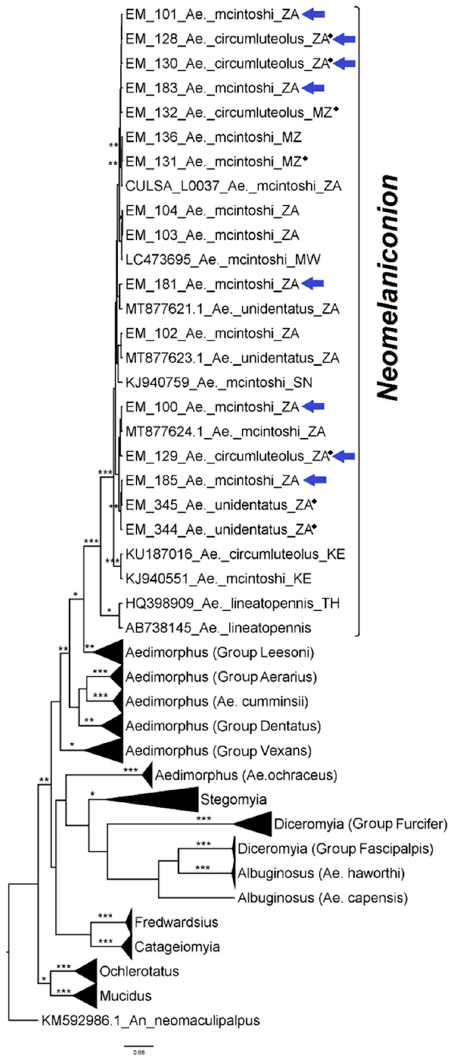
Figure 4. Phylogenetic analysis of 172 partial coxI nucleotide sequences from mosquitoes of the genus Aedes , presenting the subgenus Neomelaniconion . At specific branches, the number of * indicates the tree topological support revealed by the different phylogenetic reconstruction methods, assuming relevant bootstrap and aLRT values above 75% and posterior probability values above 0.80. The sequences obtained in this work are indicated with the “EM” code, and those with associated genitalia are indicated by horizontal blue arrows. The sequences downloaded from GenBank and Boldsystems are indicated by their respective accession numbers and access codes (respectively); the symbol “.” after the code of our sequence indicates that said sequence was not identified by Boldsystems. Their country of origin [South Africa (ZA), Malawi (MW), Mozambique (MZ), Kenya (KE), Senegal (SN), Thailand (TH)] are also indicated. The vertical line marks the subgenus Neomelaniconion and the collapsed branches indicate the species of the subgenera and/or informal groups of the